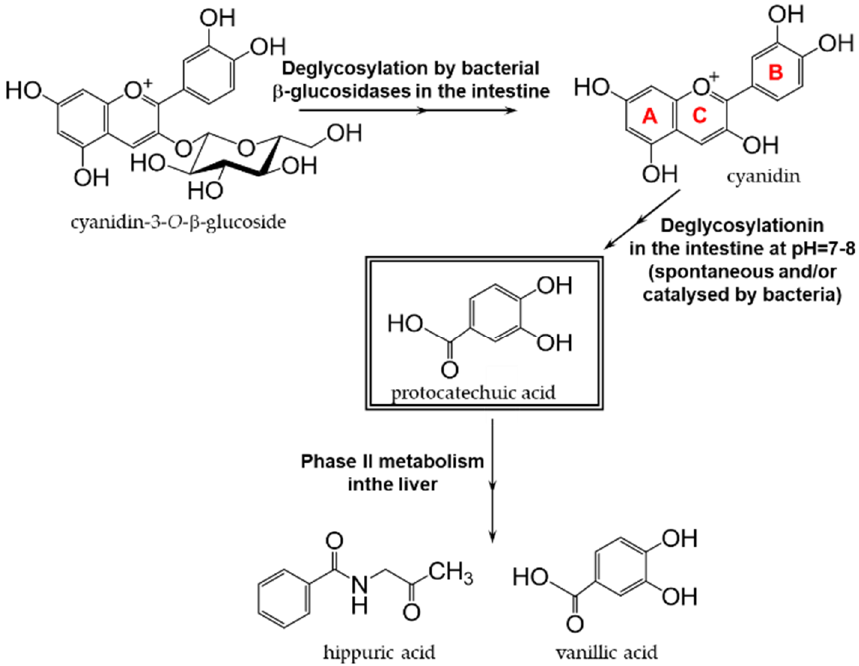
Figure 17. Major metabolic pathway of the anthocyanin cyanidin- O - β -glucoside in humans. The presence of intestinal bacteria accelerates the formation of protocatechuic acid through cleavage of the C-ring shown in red letters in figure. Modified from [286].